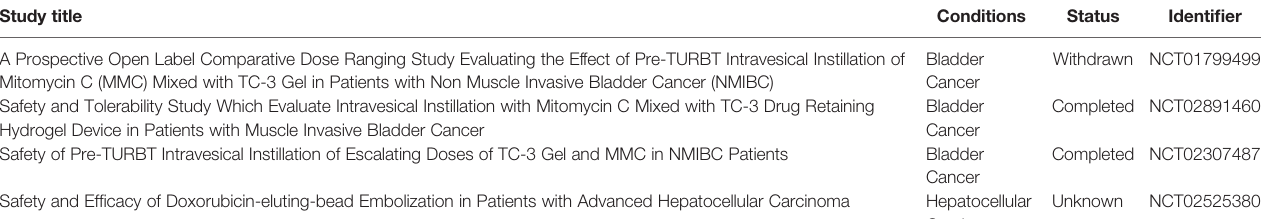
TABLE 1 | Drugs embedded in hydrogels were used to treat cancers based clinical trials up to September